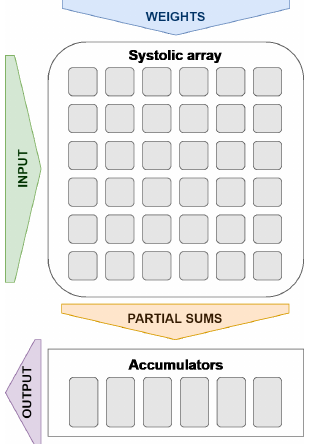
Figure 6. Systolic array in the Google